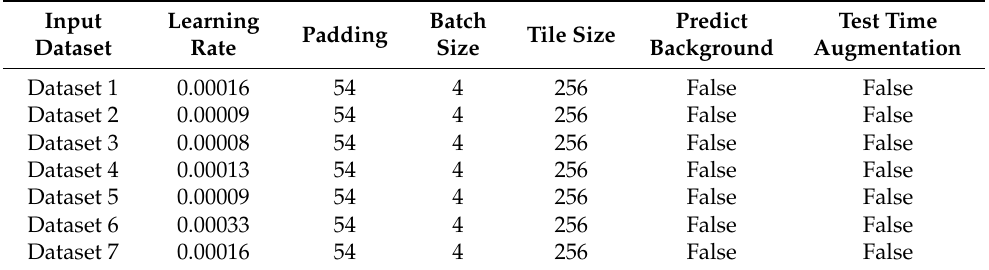
Table 3. Deep learning parameters used in U-Net prediction